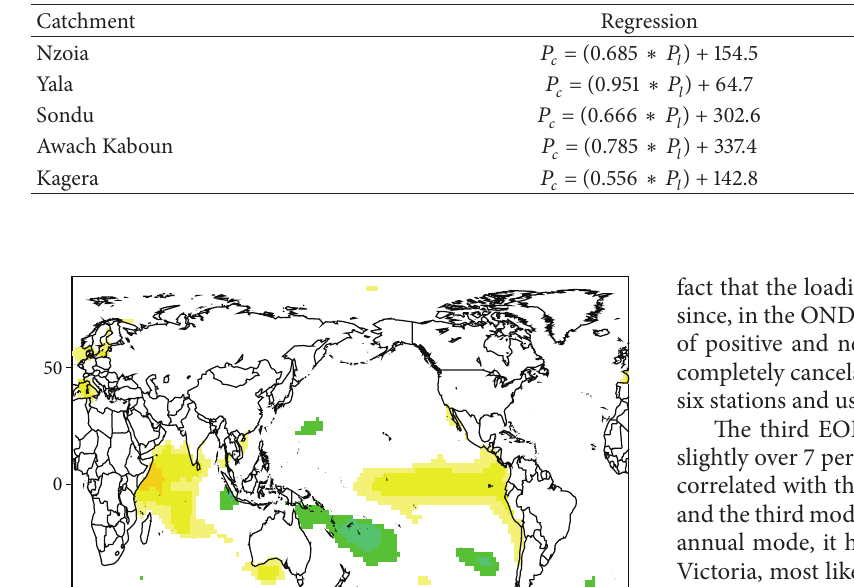
Table 1: Regressions of rainfall for 1956–1990. 𝑃 𝑐 is catchment rainfall; 𝑃 𝑙 is lake rainfall (from Tate).